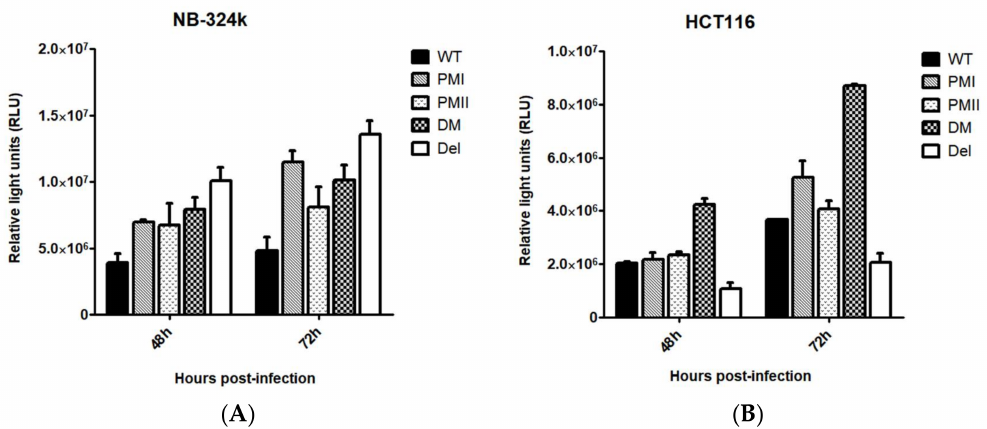
Figure 4. Quantification of luciferase transduction in human NB-324k and HCT-116 cells infected with modified recombinant H-1PV-based vectors. Using 3 × 10 5 cells, NB-324k ( A ) and HCT-116 ( B ) cells were infected with Chi-H1/Gluc, Chi-H1-PM-I/Gluc, Chi-H1-PM-II/Gluc, Chi-H1-DM/Gluc, and Chi-Del H1/Gluc (MOI, 3 RU/cell). At 48 and 72 h post-infection, Gaussia luciferase activity was determined in the cell culture medium and expressed as relative units. Values are the mean ± SD of three measurements from